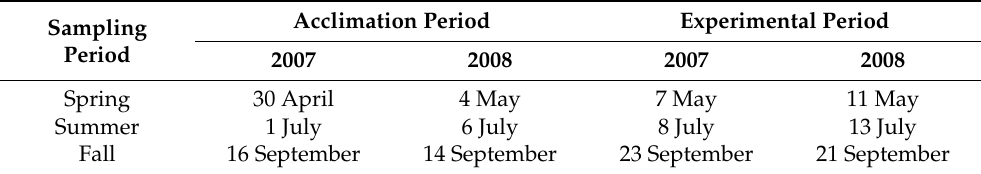
Table 1. Sampling schedule at the US Dairy Forage Research Center farm near Prairie du Sac, WI,